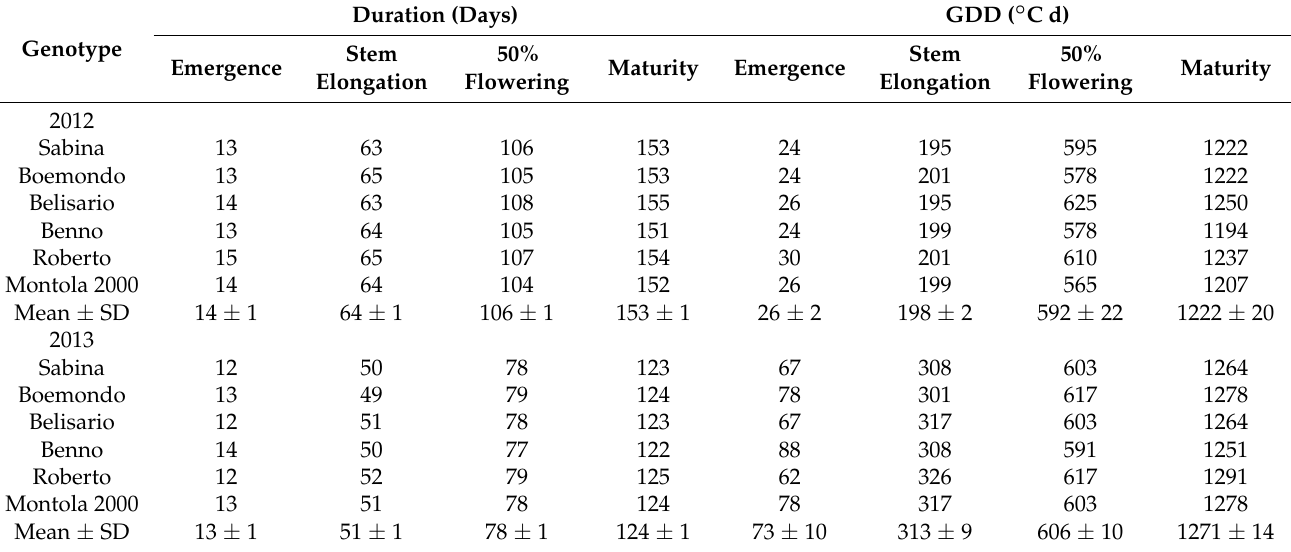
Table 4. Duration and cumulative growing degree days (GDD) required from sowing to emergence, stem elongation, 50% flowering, and maturity of six safflower genotypes across two growing seasons. Phenological stages according to Flemmer et al.